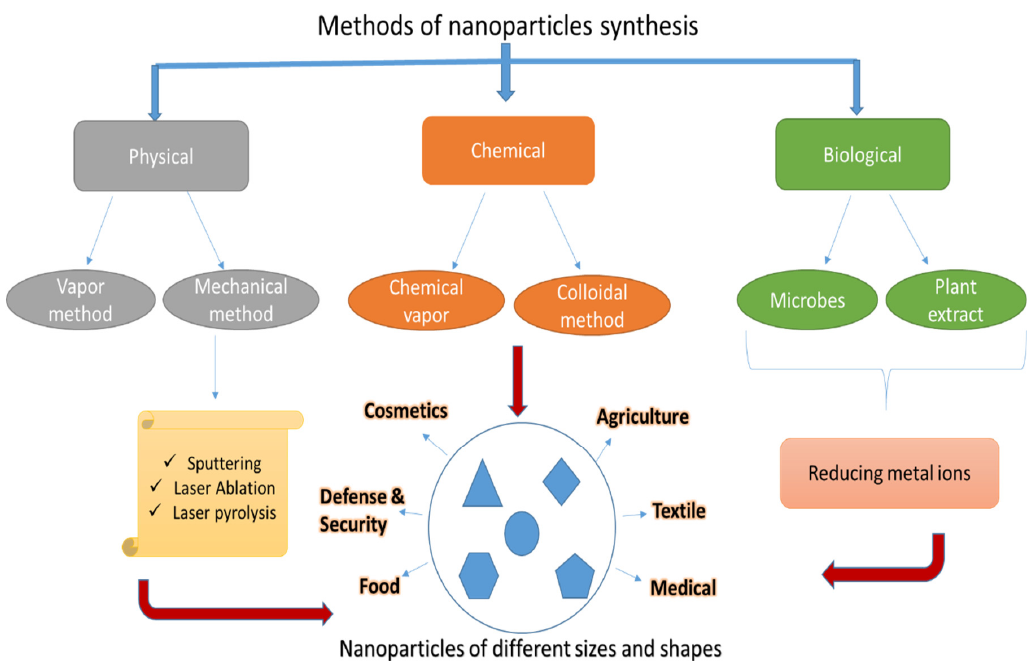
Figure 1. Different techniques for synthesis of nanoparticles including: (physical), which is size and shape dependent; (chemical), the synthesis of NPs from precursor chemical such as polyvinyl alcohol, ethylenediamine tetraacetic acid (EDTA), oliec acids and many others; and (biological) synthesis from plants, bacteria, and fungi. a) Properties associated with physical, chemical, and biological synthesis of NPs.